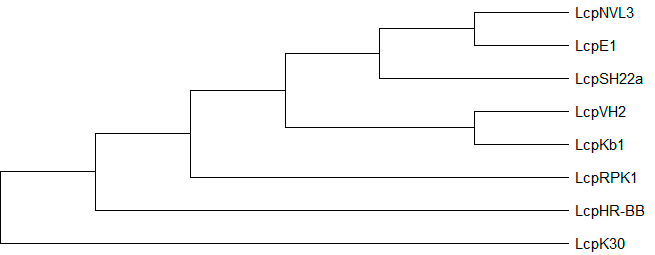
Figure 5. Phylogenetic tree of lcps using minimum evolution method was constructed using MEGA X [90]. Enzymes: Lcp K30 (AAR25849); Lcp 1VH2 (ABV68923); Lcp Kb1 (ABV68924); Lcp SH22a (WP025350295); (AMY60409); Lcp NVL3 (API85527); Lcp E1 (ABC59140) and Lcp HR ‐ BB